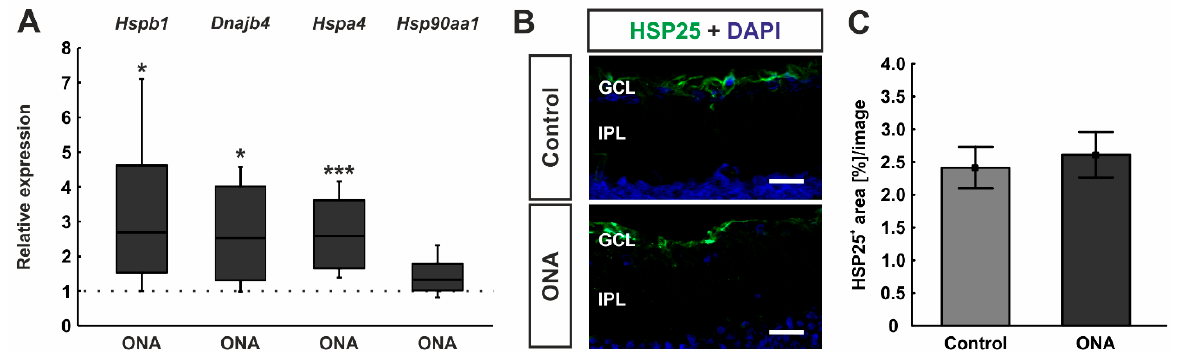
Figure 3. Upregulation of heat shock proteins after immunization. ( A ) The relative expression of Hspb1 (HSP27) was significantly upregulated in ONA retinae ( p = 0.036). In addition, the mRNA expression of Dnajb1 (HSP40; p = 0.038) and Hspa4 (HSP70; p < 0.001) were upregulated in ONA retinae compared to controls. The mRNA expression levels of Hsp90aa1 (HSP90) were not altered after ONA immunization. ( B ) Retinal cross-sections were labelled against anti-HSP25 (green; rat homologue for HSP27), while cell nuclei were counterstained with DAPI (blue). ( C ) The HSP25 + area was similar in ONA and control animals. Scale bars: 20 µm. GCL = ganglion cell layer; IPL = inner plexiform layer. Values for RT-qPCR are median ± quartile ± minimum/maximum and values for immunofluorescence are mean ± SEM. The dotted line in ( A ) represents the relative expression of the control group. * p < 0.05, *** p < 0.001.